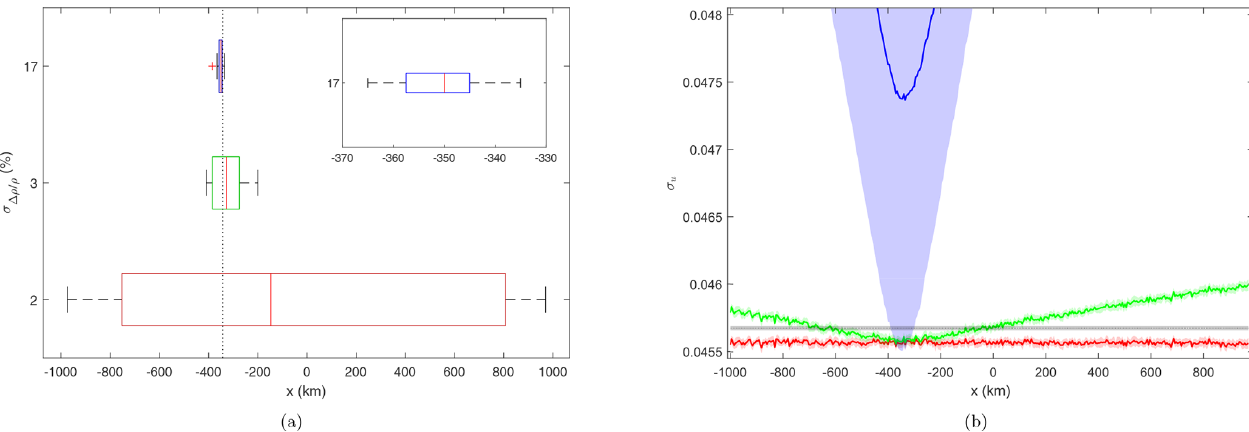
Figure 8. Influence of fluctuation level in simulations assuming a single irregularity region in the inbound region. (a) Box chart comparing different rms fluctuation levels. The vertical dashed line indicates the bubble placement. The detection improves significantly when the fluctuations level is σ (cid:49)ρ/ρ > 3 . 0% ( ± 2 . 64 × 10 10 elm − 3 ), with an estimate median x = − 327 . 5km achieved with such a set-up. Weaker irregularities, e.g. σ (cid:49)ρ/ρ = 2%, are not distinguishable from the receiver noise and yield a poor location estimate of the irregularity patch. (b) BP amplitude standard deviation. Shaded regions depict the 2 σ interval. The same colour scheme is used in both figures, and the grey line represents the receiver noise level. Figures depict results assuming 20 realizations for each fluctuation level.